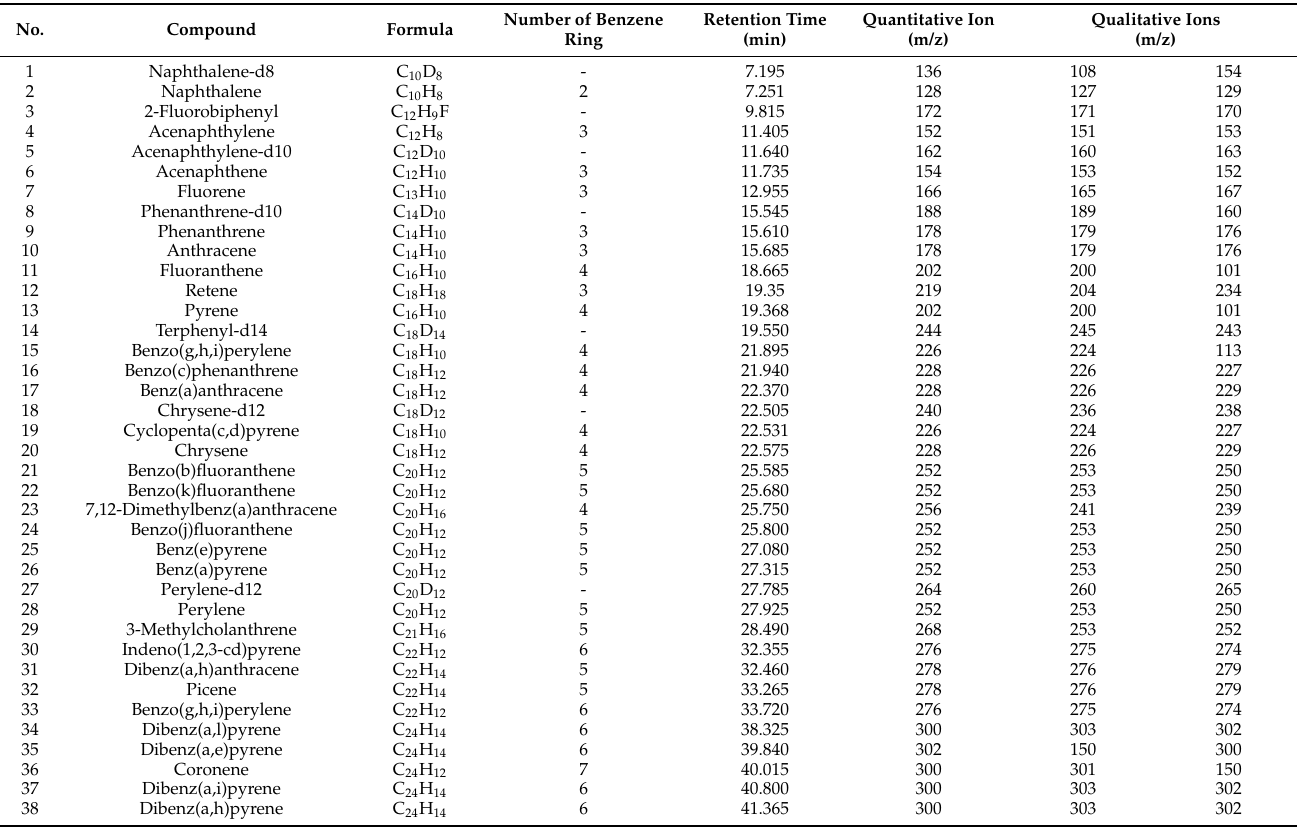
Table 1. Retention times, quantitative ions, and qualitative ions of